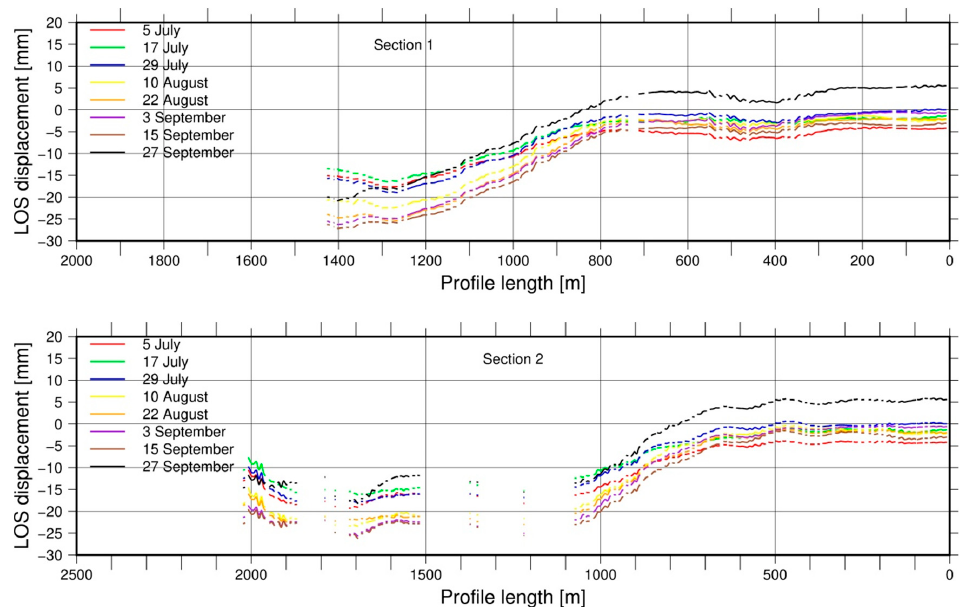
Figure A4. Time series for track 154. All LOS displacements in each of the time periods. The reference time period is 22 May. Remote Sens. 2020 , 12 , x FOR PEER REVIEW